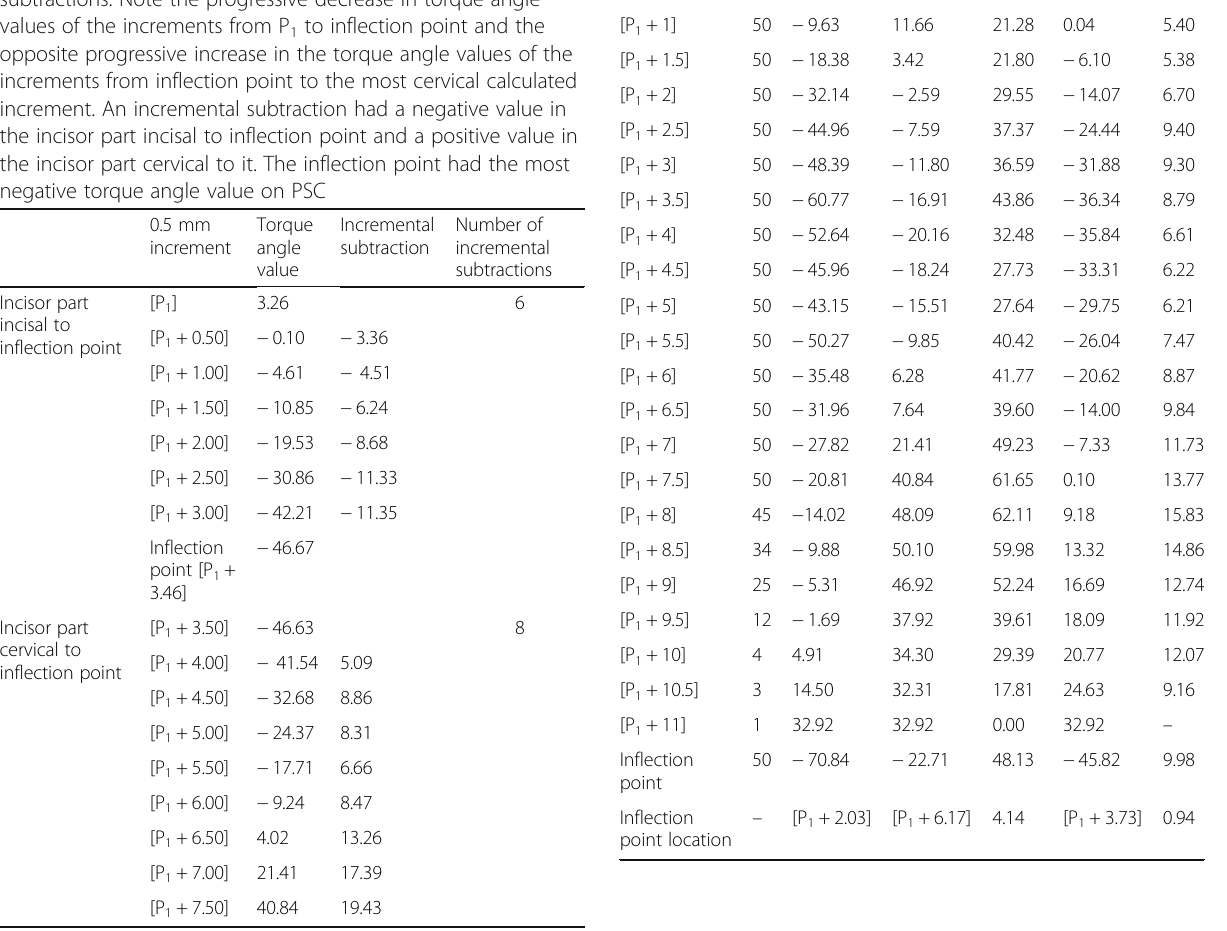
Table 2 Descriptive statistics of the torque angle values of the PSC of the 50 incisors from [P 1 ] to [P 1 + 11] and at the inflection point. Descriptive statistics of the inflection point